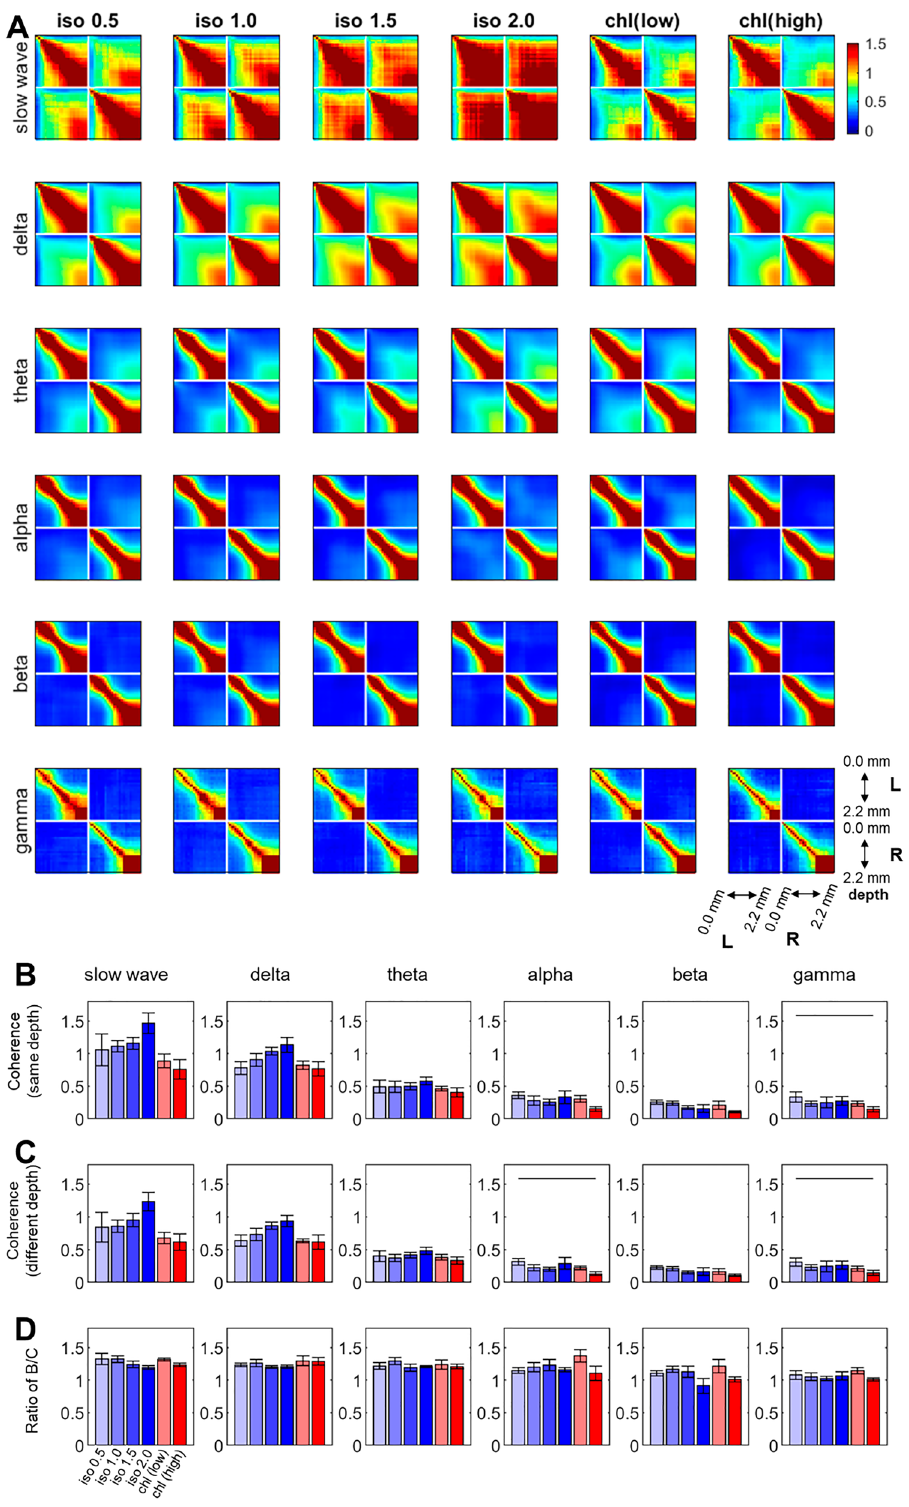
Figure 4. Band coherences of spontaneous LFP activities across varying anesthesia conditions. ( A ) Z-statistics for band coherence using Fisher transformation. ( B ) Average z-statistics at same depth. ( C ) Average z-statistics at different depths. ( D ) Layer-specificity of inter-hemispheric coherences (Ratio of B/C). Horizontal bar: p < 0.05 in post-hoc Tukey’s test. (n = 8. Group